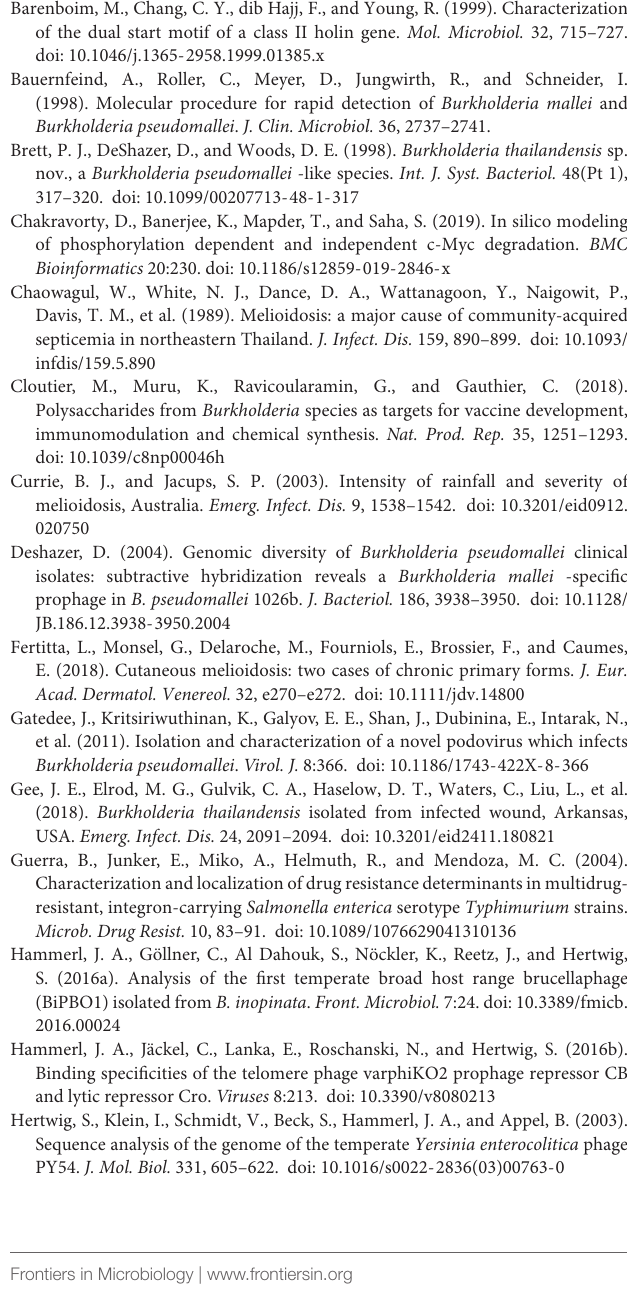
FIGURE S2 | Plaque morphology of (cid:56) Bp10 on B. mallei isolate GB5. Plaque formation on a section of an overlay agar plate is shown. The black bar represents a reference standard of 10 mm.